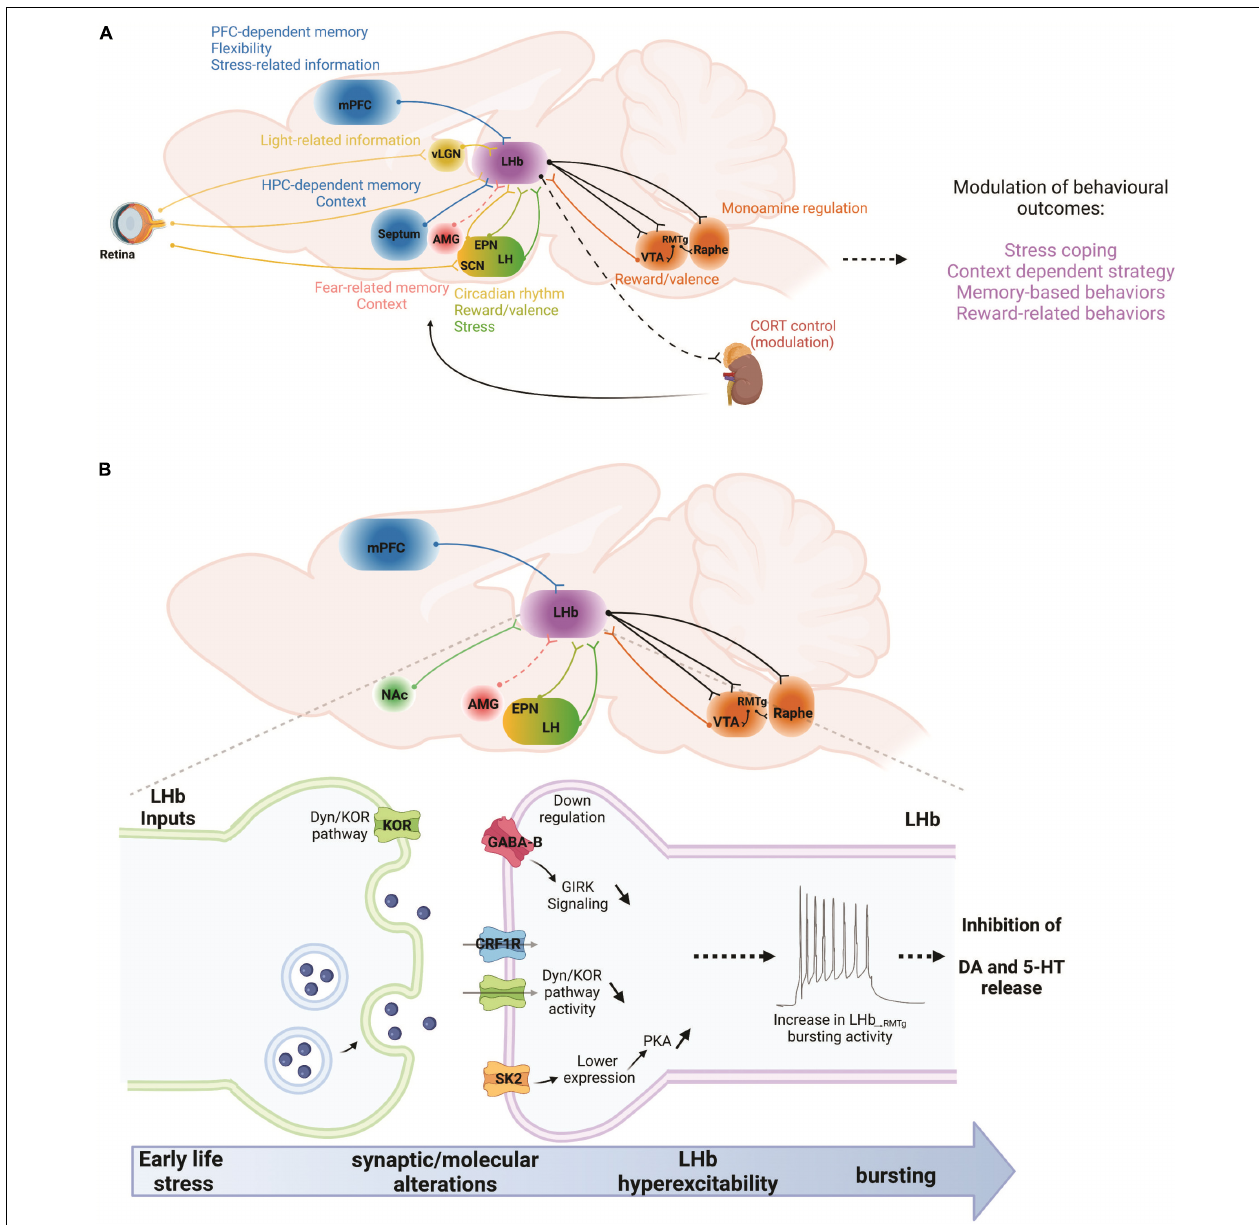
FIGURE 1 | (A) In a given situation, the LHb can be viewed as a recipient of multiple types of information stemming from cortical and subcortical regions. Those include memory- and flexibility-related information from the mPFC, or hippocampal memory-related information from the septum. Emotional information arises from the AMG while stress-related information from the mPFC and the LH. Reward and valence-related information reach the LHb from the EPN and the dopamine system. Finally, light-related information reaches the LHb from the retina, either directly or through the vLGN and SCN. Once the LHb has processed this information, they are communicated to the dopamine and serotonin systems, as well as to the HPA axis in order to adapt behavioral responses to changes in environmental constraints. AMG, amygdala; CORT, corticosterone; EPN, entopeduncular nucleus; HPC, hippocampus; LH, lateral hypothalamus; LHb, lateral habenula; mPFC, medial prefrontal cortex; RMTg, rostromedial tegmental nucleus; SCN, suprachiasmatic nucleus; vLGN, ventral lateral geniculate nucleus; VTA, ventral tegmental area. (B) Early life stress, such as maternal deprivation (MD) and repeated daily maternal separation (MS) lead to LHb hyperexcitability. Maternal deprivation in particular also increases LHb neuronal bursting and intrinsic excitability. MS-induced LHb hyperactivity is the consequence of altered input communication from at least the EPN with down-regulation of GABABR-GIRK signaling. On the other hand, MD dysregulates Dyn/KOR and CRF-CRFR1 signaling pathways while increasing PKA activity that promotes the downregulation of small conductance (SK2) potassium channels. Increases in LHb bursting and activity can in turn downregulate dopaminergic and serotonergic transmissions through hyperactivation of the RMTg, and therefore promote stress-related disorders such as anxiety and